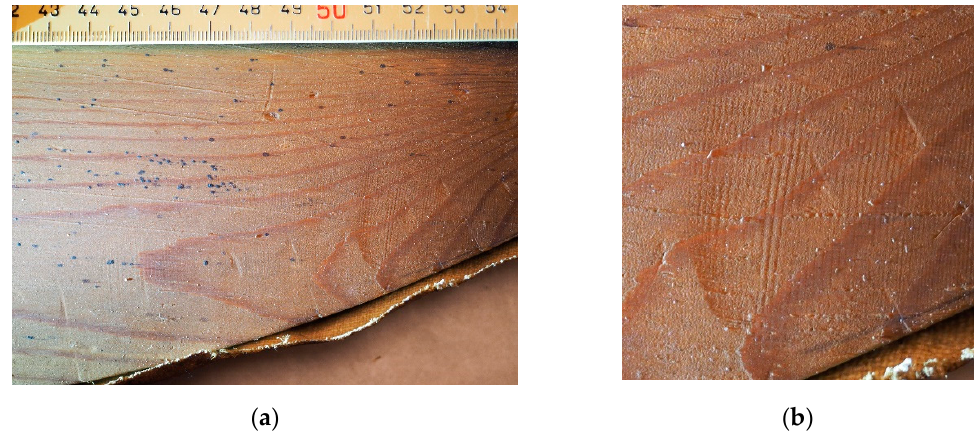
Figure 5. The wooden surface of the original strainer of E. Moltke (SV6): ( a ) showing longer linear lines from the plane iron, rippling from the hand plane and canvas-plier indentations; ( b ) enhanced detail of rippling from the hand plane.